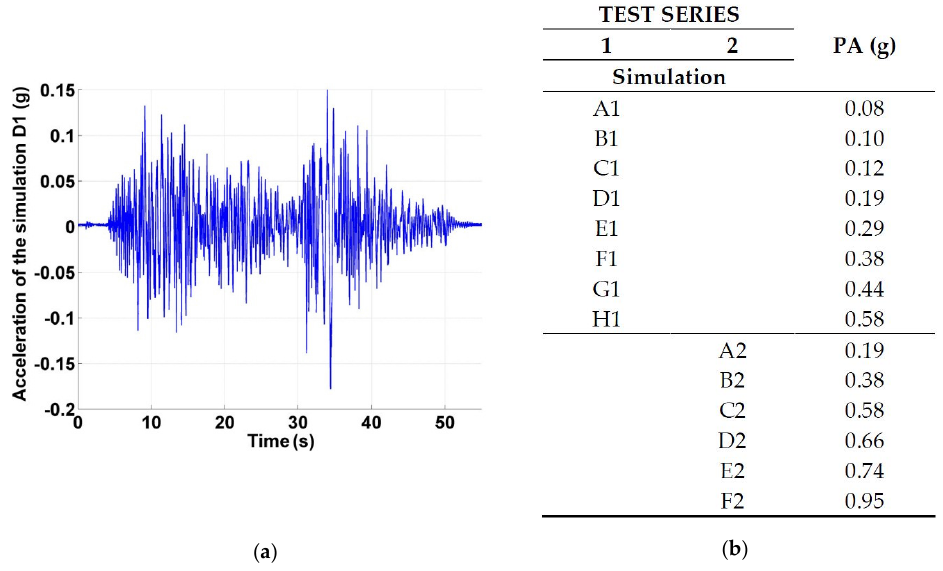
Figure 16 . ( a ) Acceleration of Campano ‐ Lucano earthquake scaled at 100% (Simulation D1). ( b ) Seismic simulations (name and Peak Acceleration (PA)).